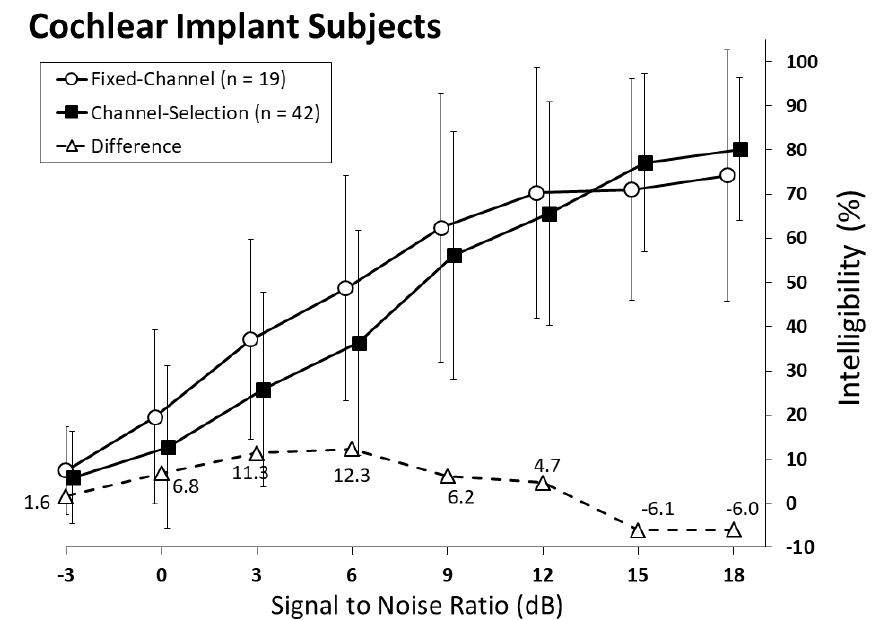
Figure 4. Syllable recognition function of the signal-to-noise ratio by CI users. Bars indicate the standard deviation. The asterisks indicate the significant differences (5% threshold).